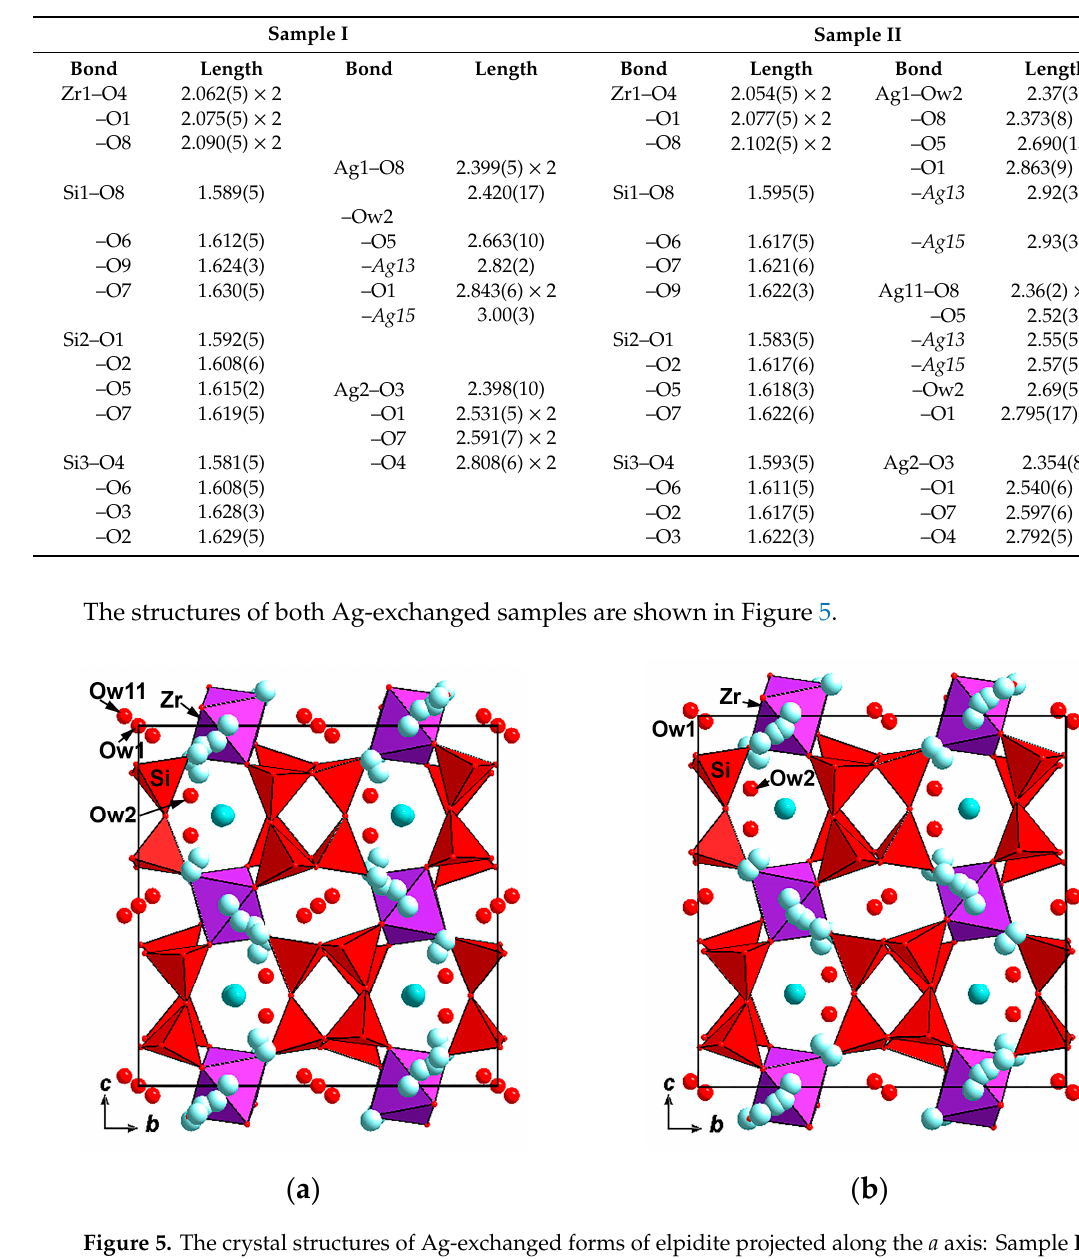
Table 7. Selected interatomic distances (Å) in the structures of Ag-exchanged forms of elpidite (samples I and II). For extra-framework cations, the distances are given only for the sites with s.o.f. higher than 10%. The Ag13 and Ag15 sites are involved in the coordination spheres of other Ag sites due to the assumption that at these sites, H 2 O molecules dominate over Ag.